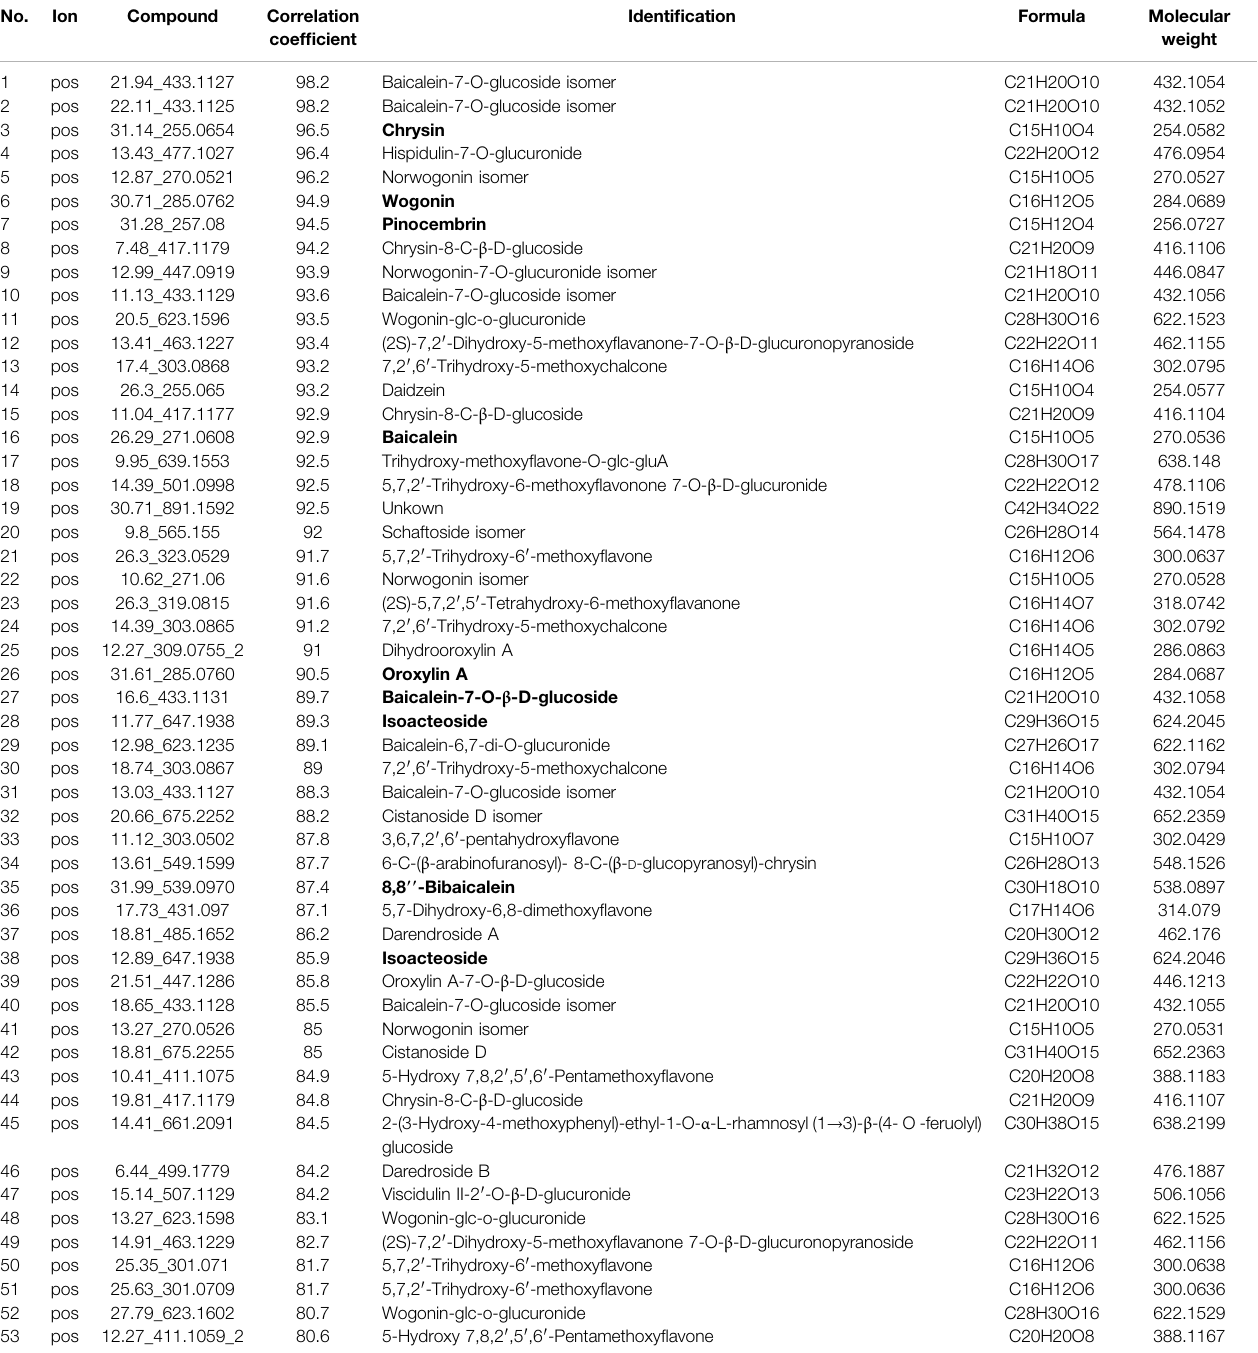
TABLE 2 | Identi fi cation of components with score ≥ 80 in correlation analysis of plant metabolomics and pharmacodynamics (positive